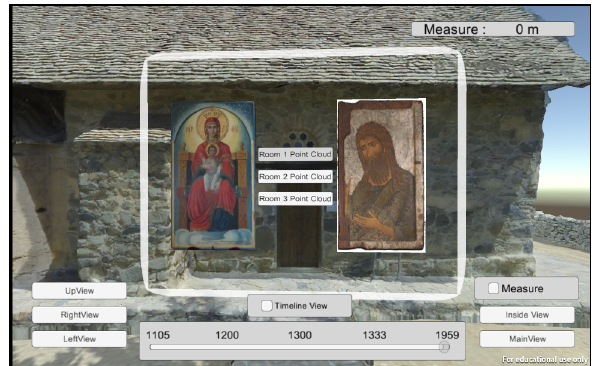
Figure 5: Geometrical model carrying semantic historical infor- mation